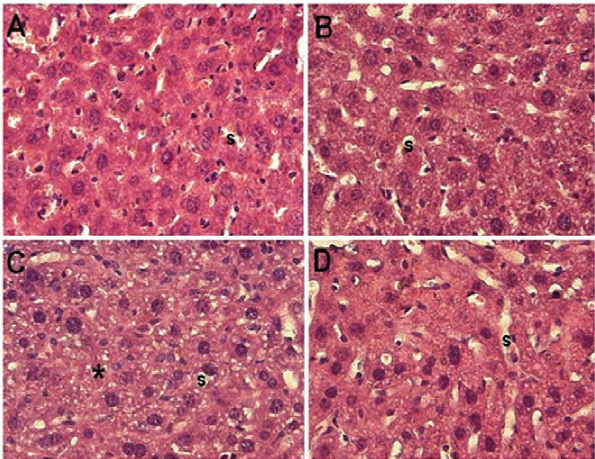
Figure 3. Histomicrographs of mice liver of major groups. Showing histomicrographs of liver samples of various groups indicated in parentheses. All the sections have been stained with Hematoxylin and Eosin stain and were snapped at 400 6 . (A) Control [group I] depicts normal hepatocellular structure and sinusoids (s). (B) Riboflavin treated [group II] shows features very akin to normal. (C) Cisplatin treated [group III] reveals microvesicular changes in the hepatocytes as well as regions devoid of hepatocytes (*). (D) The combination of cisplatin and riboflavin treated [group IV] again shows features quite similar to normal